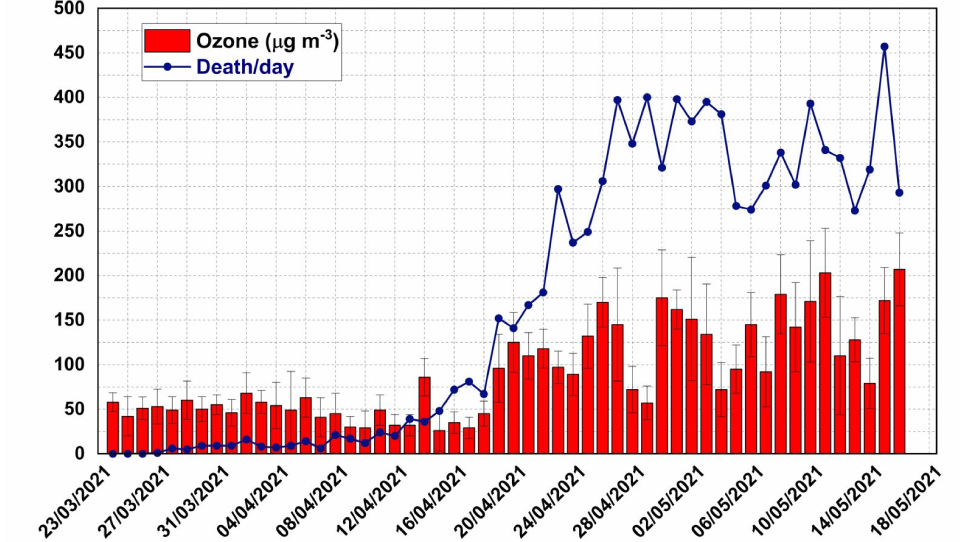
Figure 3. Co-variability of surface ozone and mortality. Daily variation in space–time-averaged surface ozone and death rate of COVID-19 patients during the peak of the second wave of the pandemic observed over